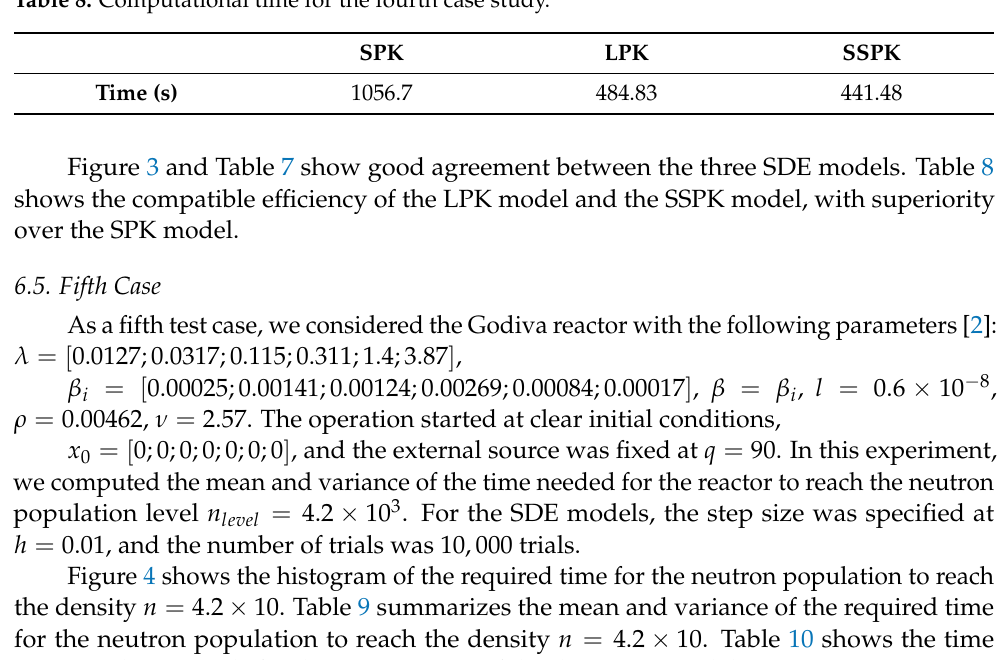
Table 8. Computational time for the fourth case